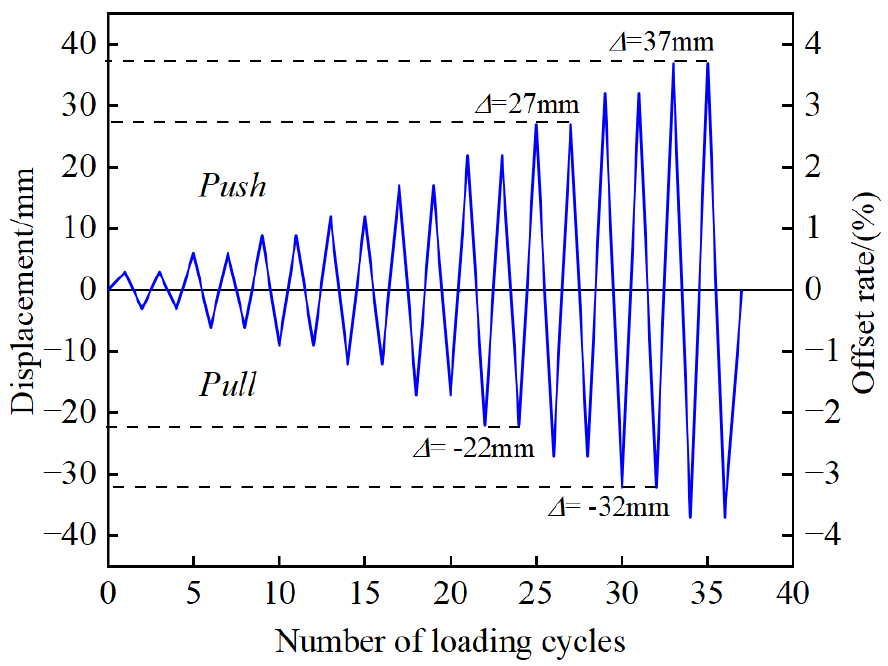
Figure 7. Displacement loading scheme.